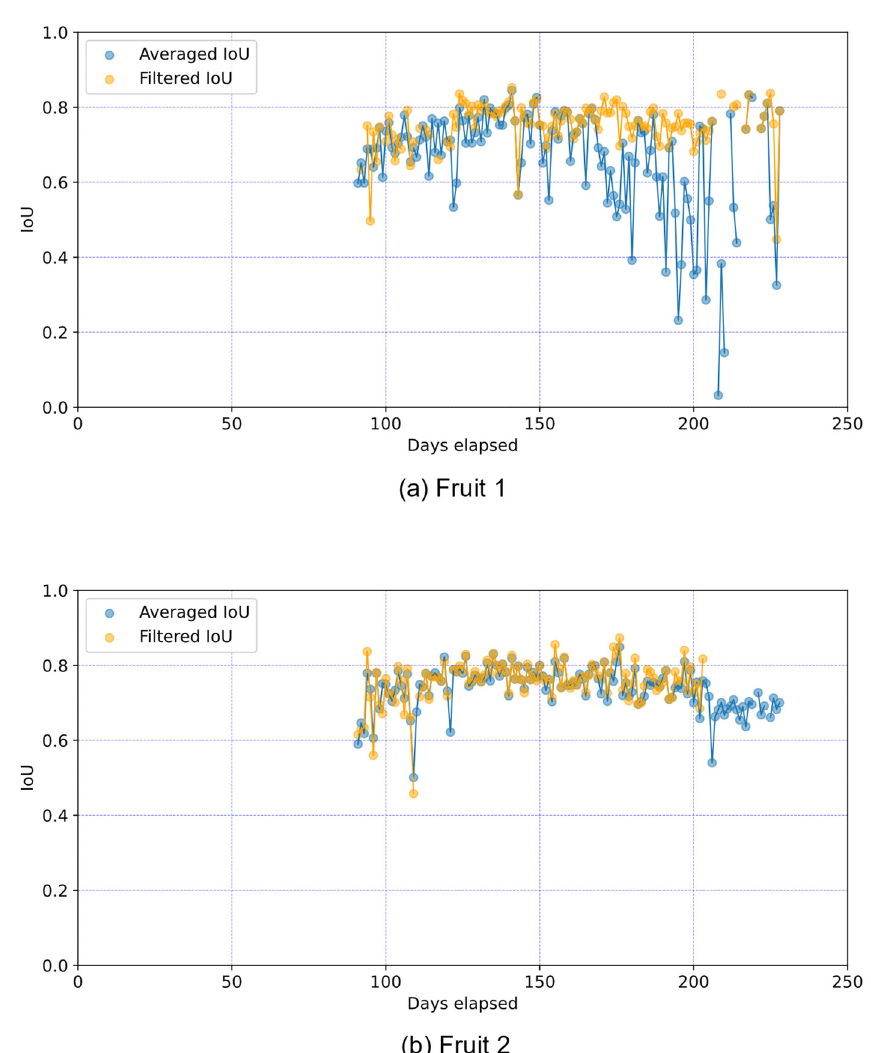
Figure 17. Filtered IoU and averaged IoU of each fruit for each elapsed day. The filtered IoUs indicate the IoUs of the fruit recognized as the same fruit by the proposed detection algorithm shown in Figure 5. The averaged IoU shows the mean value of the IoU of all fruits with the correct and overlapping regions. Although the averaged IoU of Fruit 1 is lower than that of Fruit 2 for most elapsed days due to overlaps with other fruits and leaves, the filtered IoUs of Fruit 1 and Fruit 2 are equivalent. The averaged and filtered IoUs are similar in Fruit 2 because there is little overlap with other fruits and leaves.